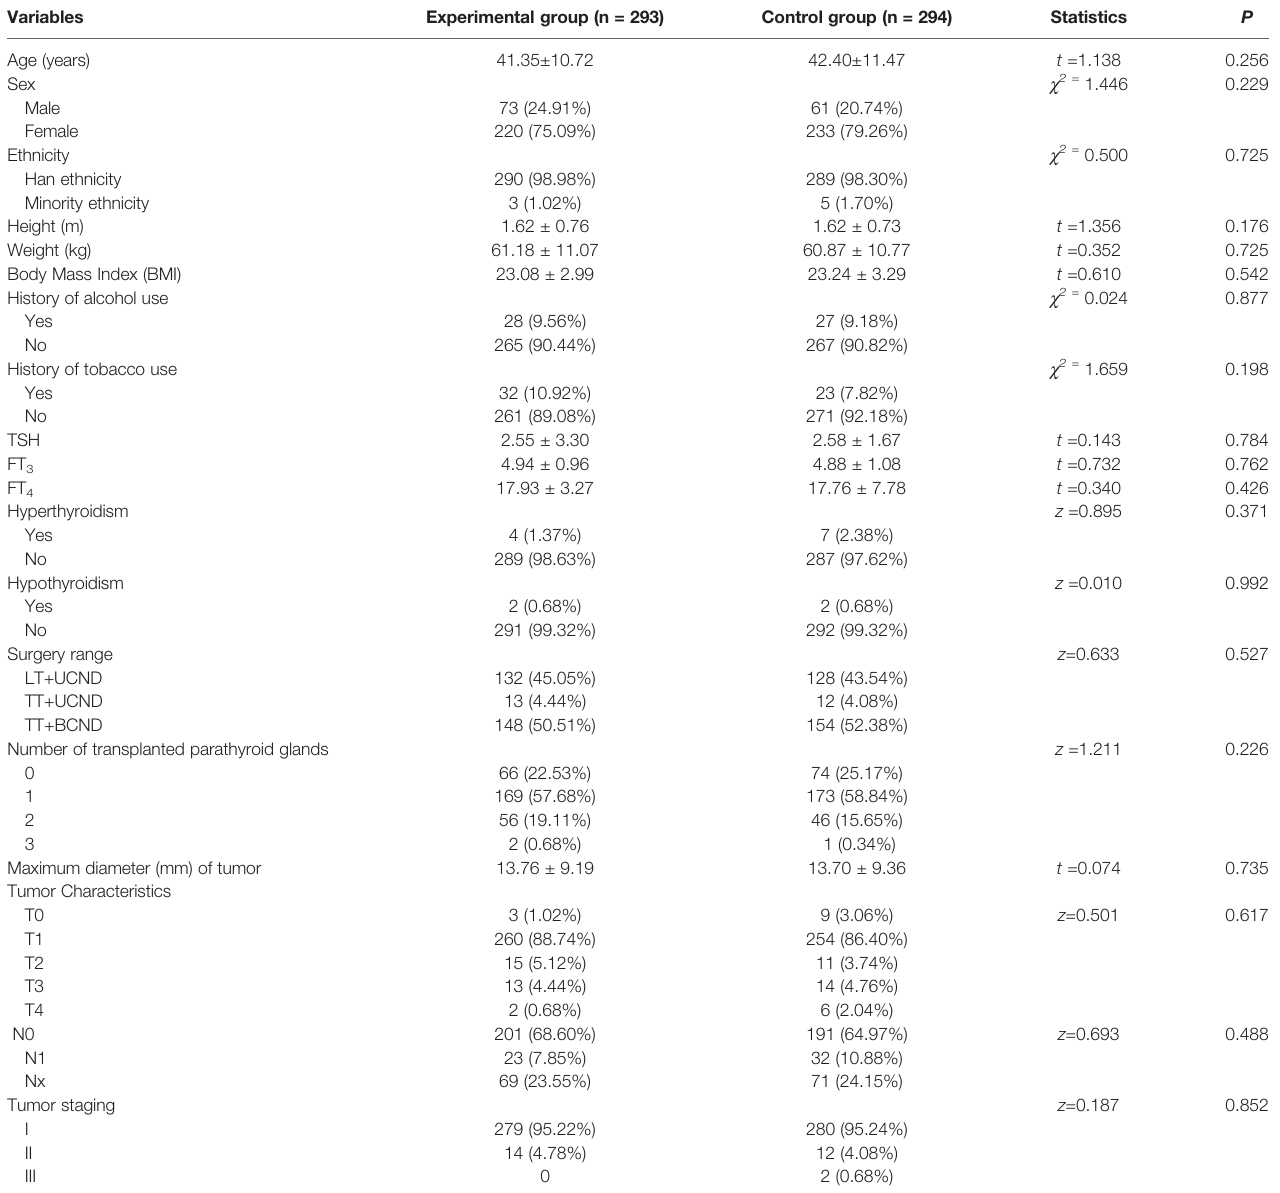
TABLE 1 | Baseline data of the